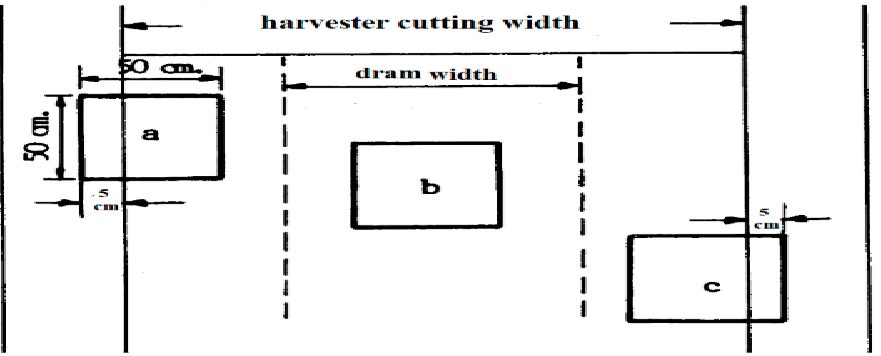
Figure 6. Frame sampling location for three quarter square frame [10].